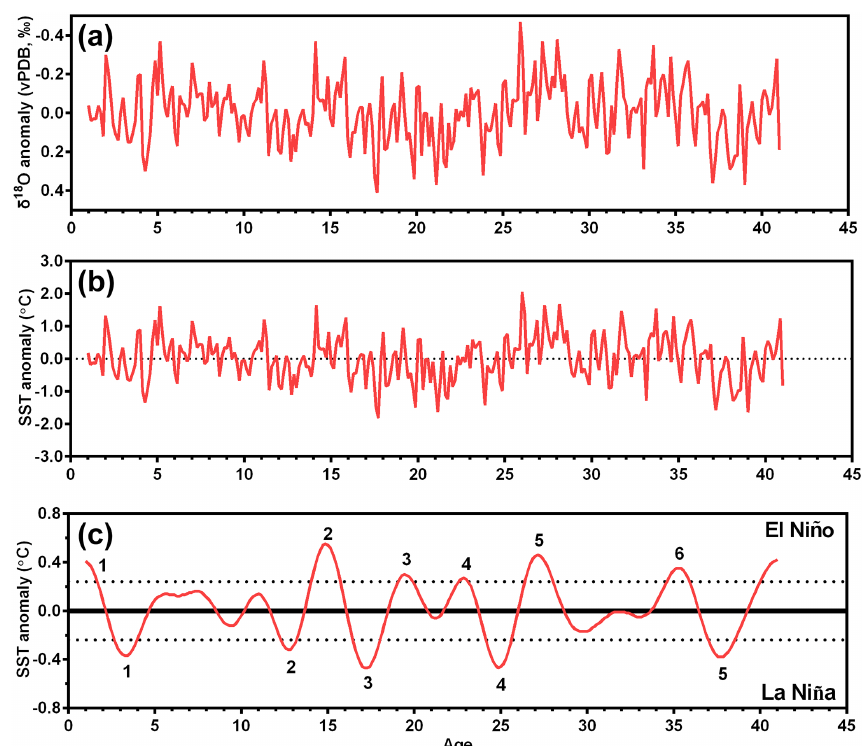
Figure 9. (a) ENSO activity reconstructed by the fossil Tridacna 3700 years ago: δ 18 O anomalies of fossil Tridacna A5. (b) The North Reef SST anomalies calculated by δ 18 O anomalies, based on modern Tridacna δ 18 O–SST equation (1‰ δ 18 O shell ≈ 4 . 41 ◦ C SST). (c) ENSO activity according to the North Reef SST anomalies after 3–7 years of bandpass filtering; the dashed lines show the calculated threshold limits (1 σ ) for ENSO